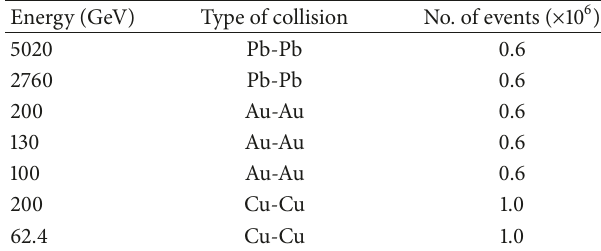
Table 1: Details of events selected for